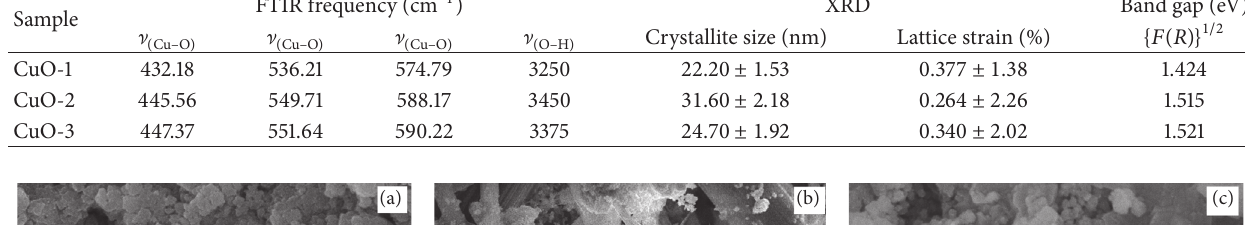
Table 1: FTIR, XRD, and DRS results of CuO NPs samples CuO-1, CuO-2, and CuO-3.